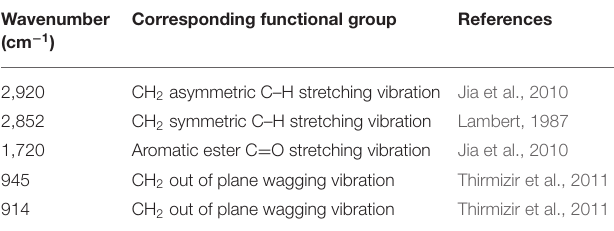
TABLE 3 | Carbonyl index and vinyl index of composites samples during accelerated weathering